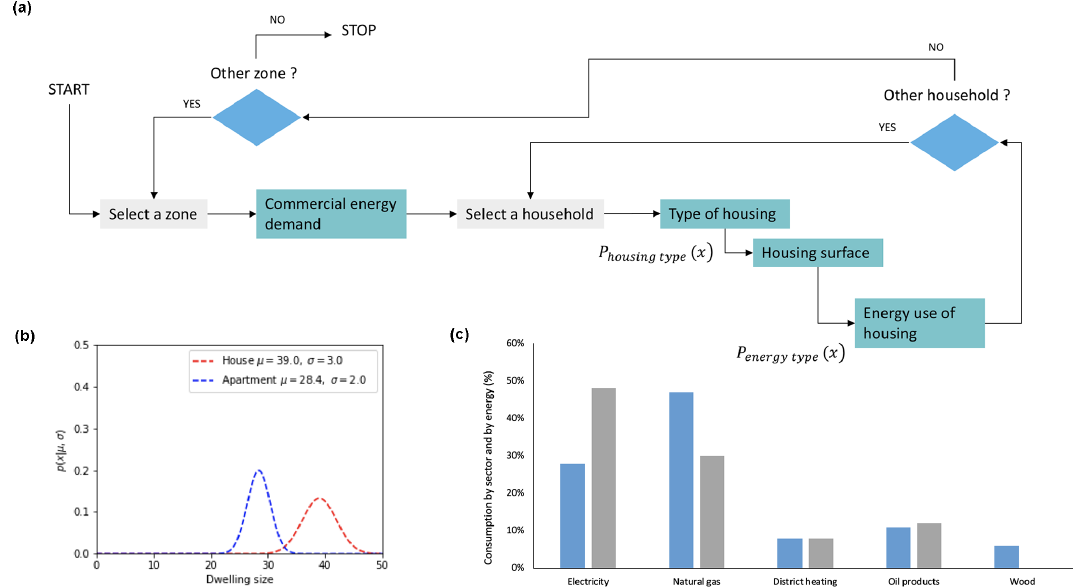
Figure 8. (a) Energy demand in the regional level generator (HESTIA) flow diagram, (b) example of dwelling size distribution and (c) prob- ability mass function of the type of energy consumed for different types of